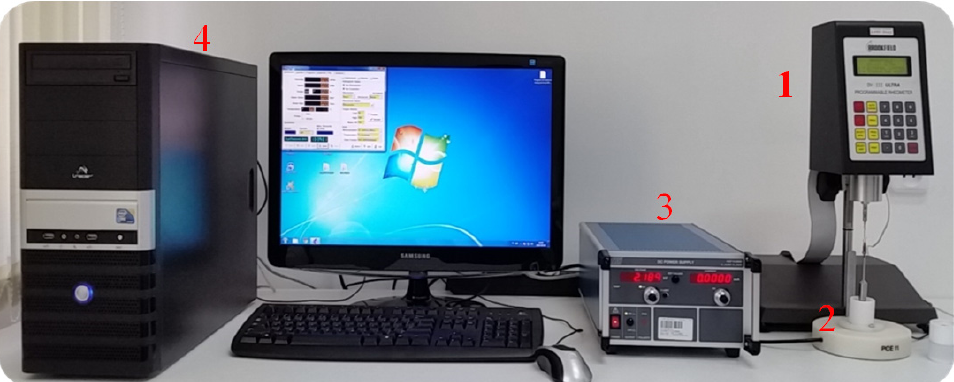
Figure 1. ER liquid testing stand: 1. Brookfield DV-III Ultra rheometer with insulated rotating spin-dle, 2. isolating adapter with cylinders equipped with electrodes, 3. high voltage power supply HCP 14-6500, 4. computer with Reocalc 32 v.2.6 control software.